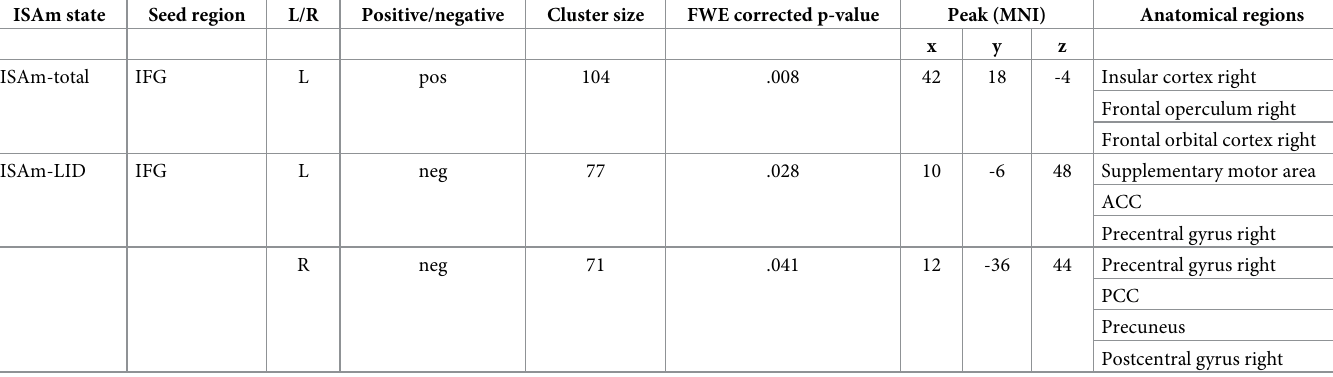
Abbreviations: LID, levodopa-induced dyskinesia; FWE, family-wise error; MNI, montreal neurological institute; IFG, inferior frontal gyrus; ACC, anterior cingulate cortex; PCC, posterior cingulate